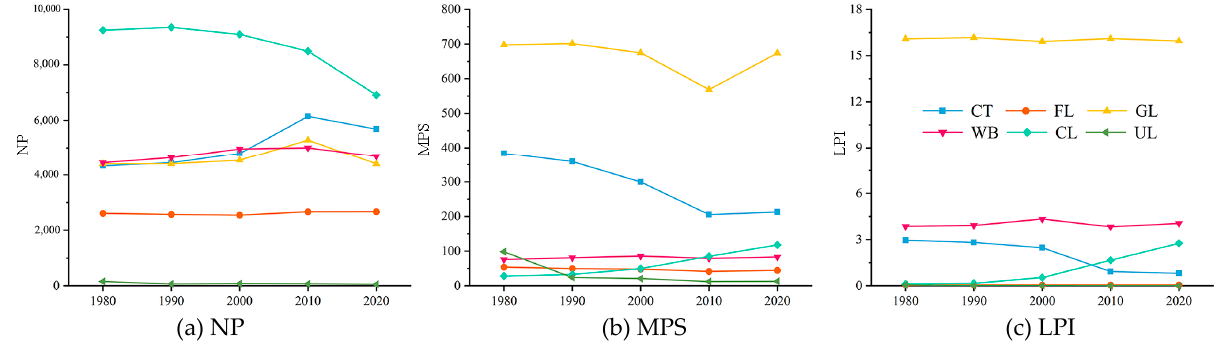
Figure 9. Landscape indices at the class level.